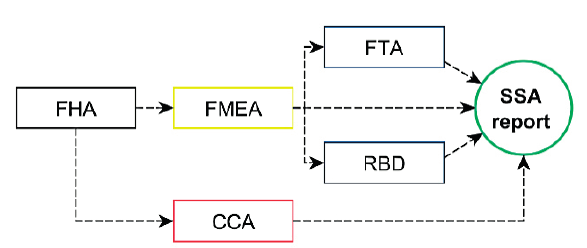
Fig. 6. The SSA process for an EASA CS-23